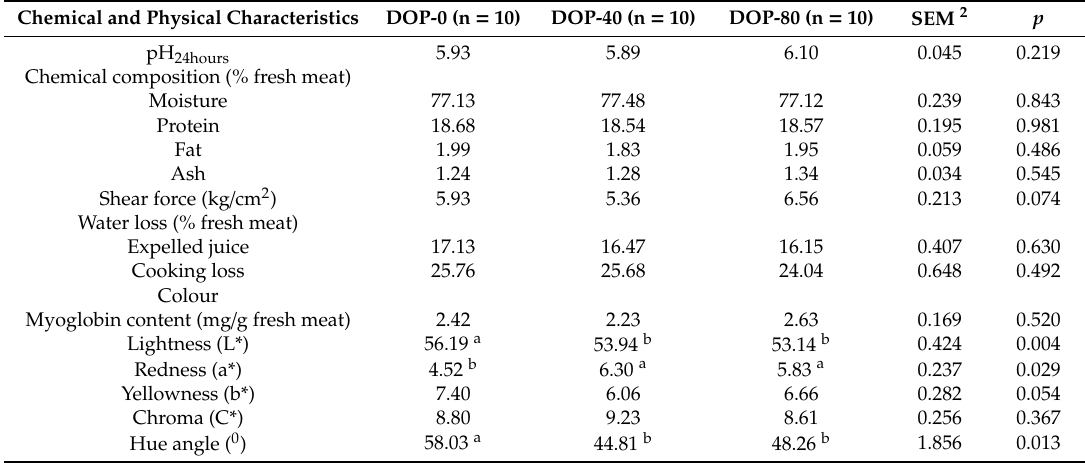
Table 3. Chemical composition of triceps brachii muscle and instrumental traits of longissimus muscle of suckling goat kids, according to the use of dehydrated orange pulp in feeding dams 1 . Chemical and Physical